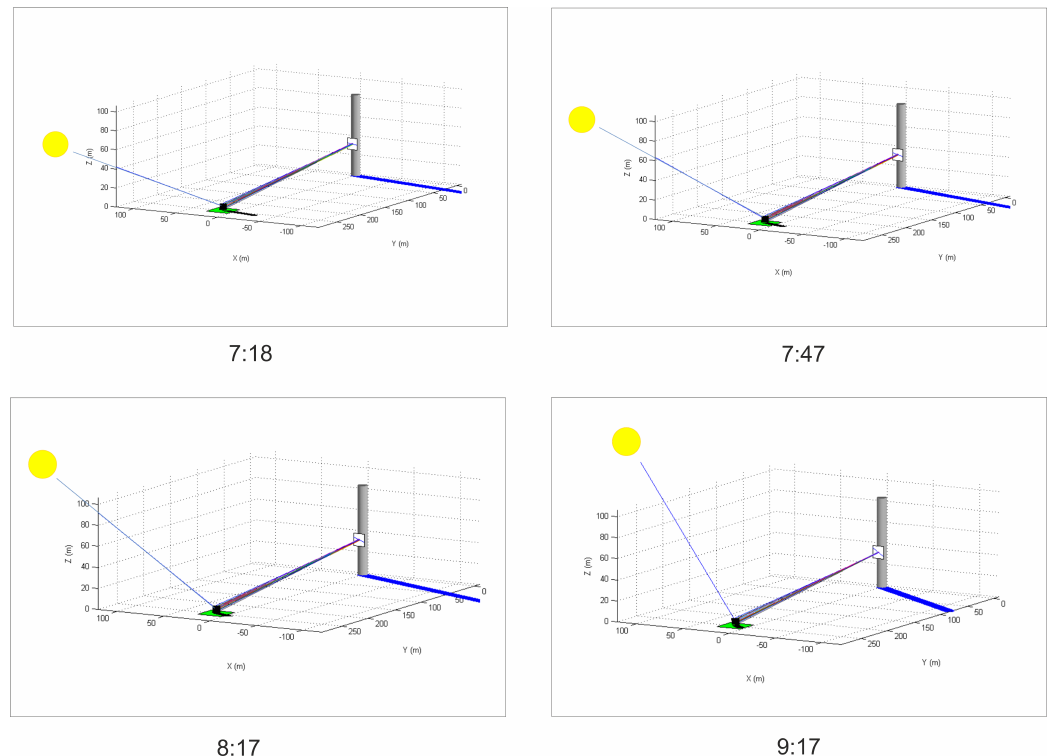
Figure 9. Scheme of the DNI forecasting simulation on the target (10 March 2017 at 7:17 UTC).